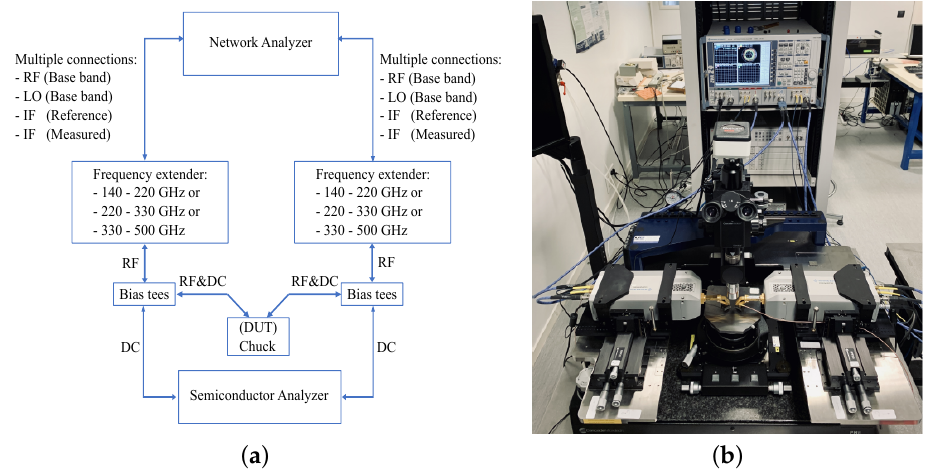
Figure 1. ( a ) Block diagram of the 140 GHz to 500 GHz measurement set-up, ( b ) photograph of the probe station for the 140 GHz to 500 GHz measurements, photo taken from [17].